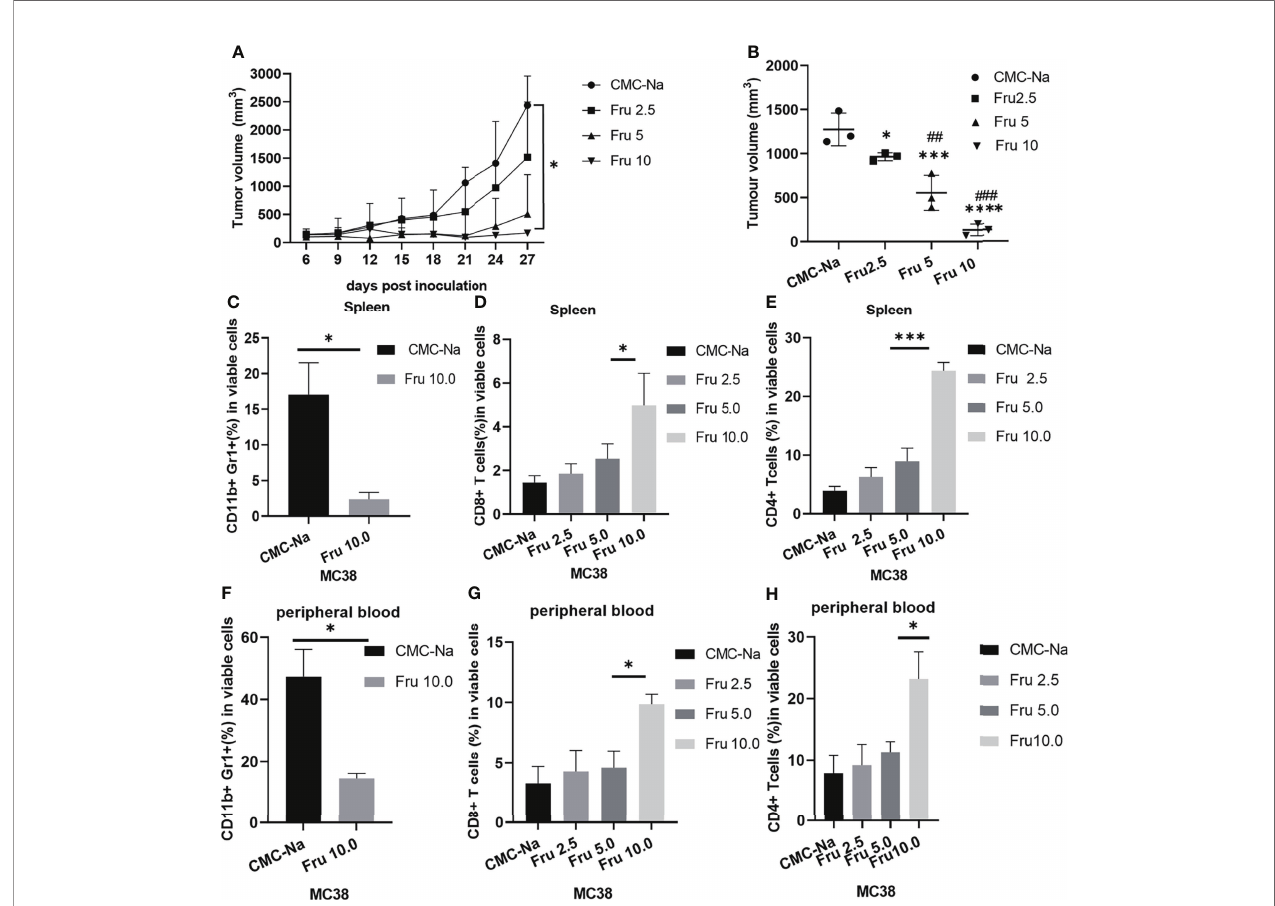
FIGURE 1 | Fruquintinib inhibits tumor growth in mouse CRC allograft tumor models. Tumor-bearing mice were treated with different doses (2.5, 5, and 10mg/kg) of fruquintinib or CMC-Na control by oral gavage daily for a total of 21days. Tumor volume and immune cells were analyzed on days 14 after fruquintinib treatment (n = 3 per group). (A) The tumor growth curve of MC38 tumor-bearing mice (p = 0.026). (B) the tumor volume measured at the 28th day after treatment (p < 0.0001). (C) MDSCs were analyzed in spleen on day14 after fruquintinib treatment. (D, E) CD8 + T cells and CD4 + Tcells were analyzed in spleen. (F) MDSCs were analyzed in peripheral blood on day14 after fruquintinib treatment. (G, H) CD8 + T cells and CD4 + Tcells were analyzed in peripheral blood on day14 after fruquintinib treament. *p < 0.05, ***p < 0.001, ****p < 0.0001. ## p < 0.01, ### p < 0.001. (* compared to control group, #compared to Fru2.5